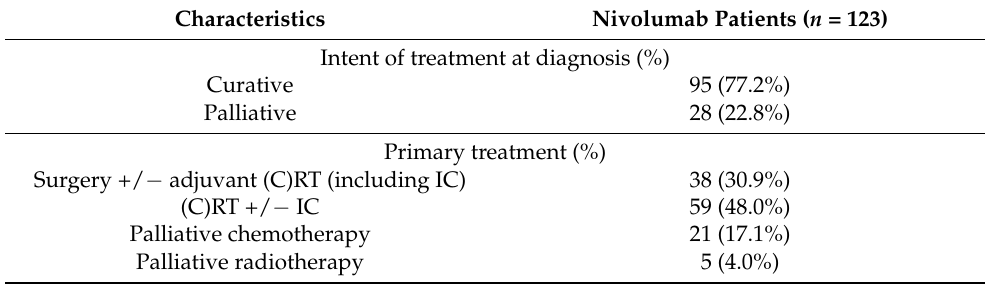
Table 2. Treatment